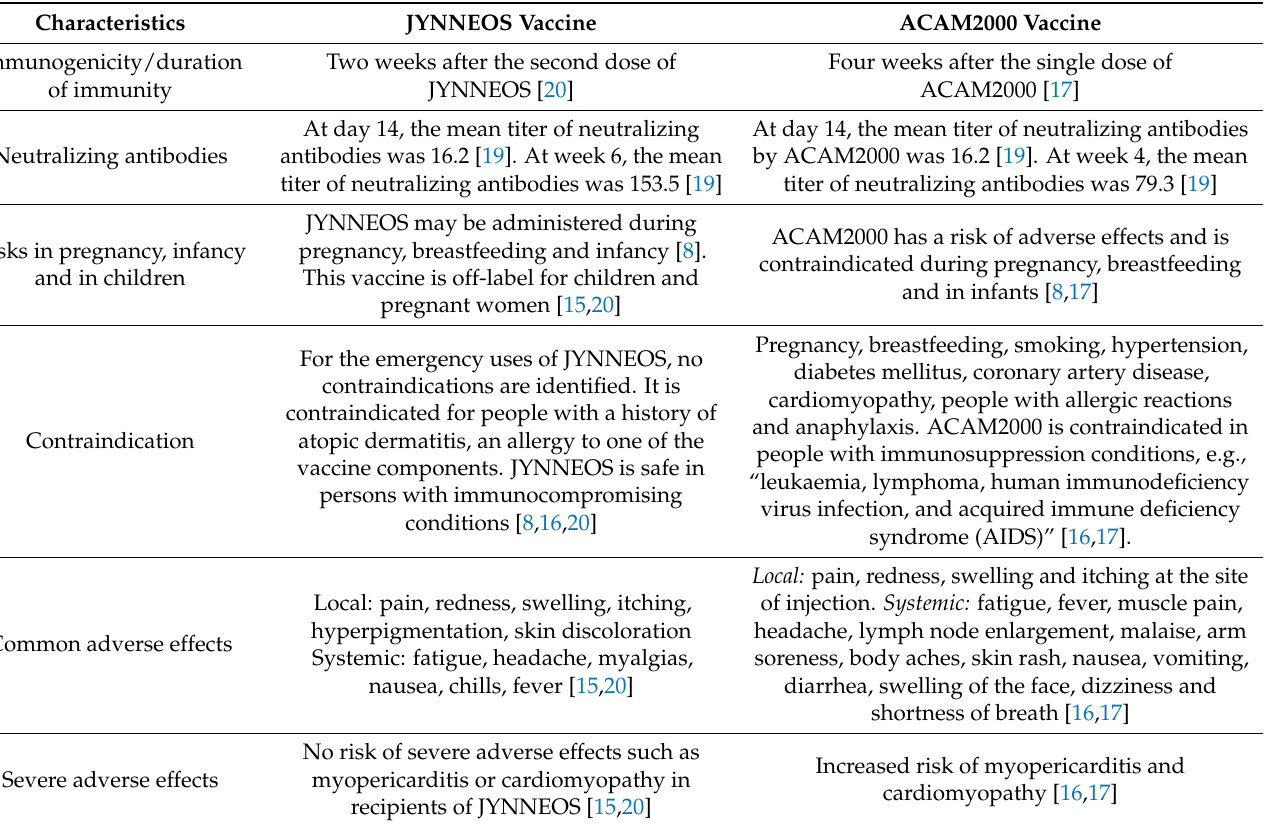
Table 2. Comparison of immunogenicity, contraindication and adverse effects between JYNNEOS and ACAM2000